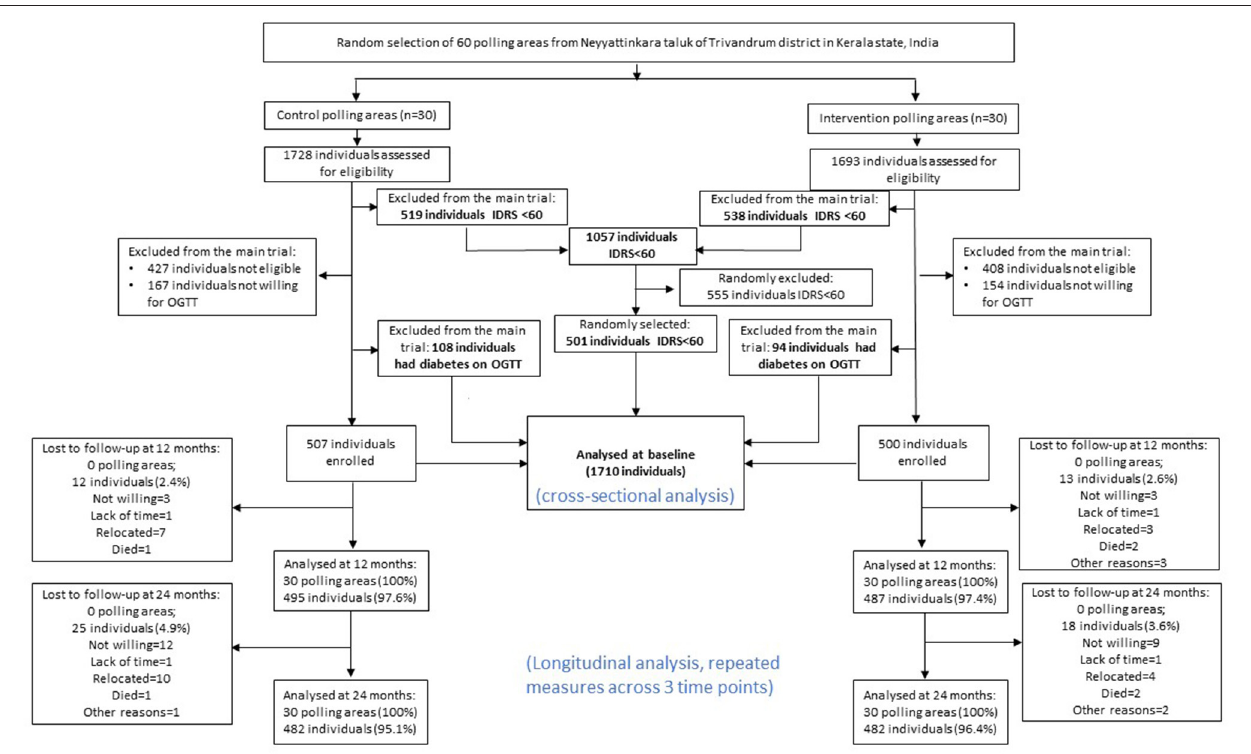
FIGURE 1 | Flow chart of the present study, adapted from previous K-DDP publications (20). IDRS, Indian Diabetes Risk Score; OGTT, oral glucose tolerance test.